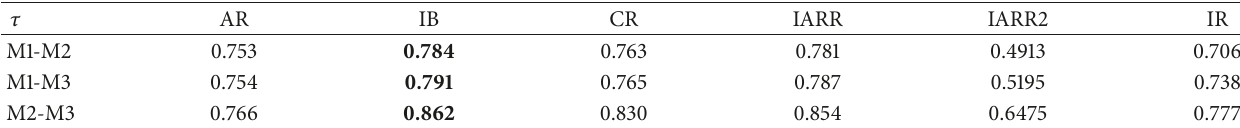
Table 6: The Kendall’s tau 𝜏 correlation coefficient of two ranked lists of common objects in two datasets . For each pair of comparison, the highest value is emphasized in